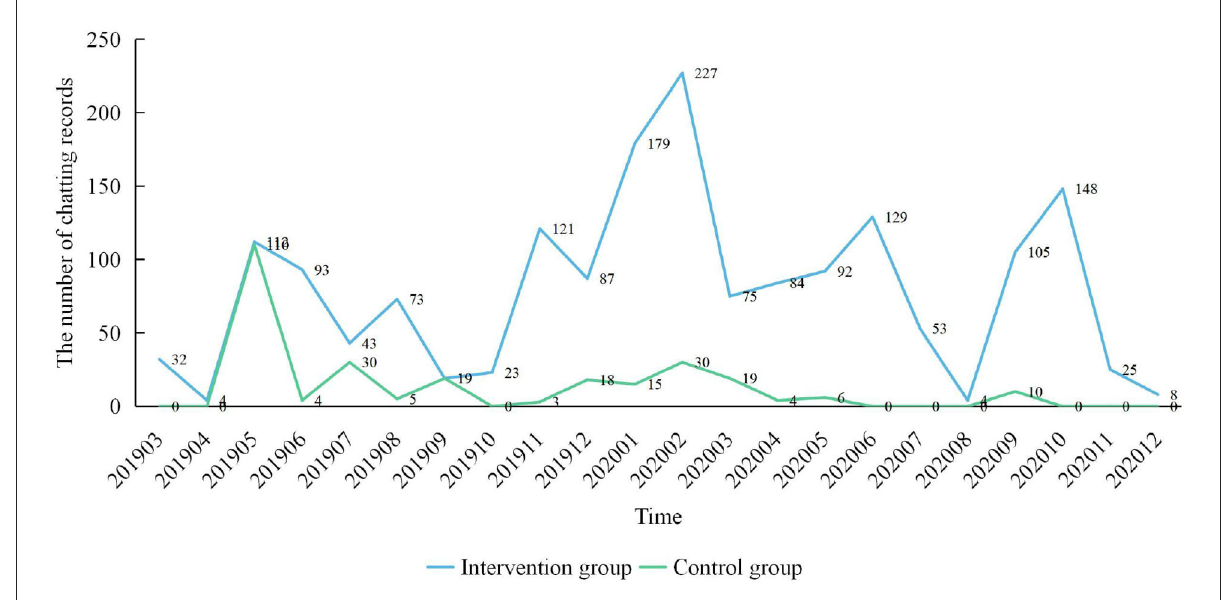
FIGURE2 The time-series plot of intervention group and control group chatting